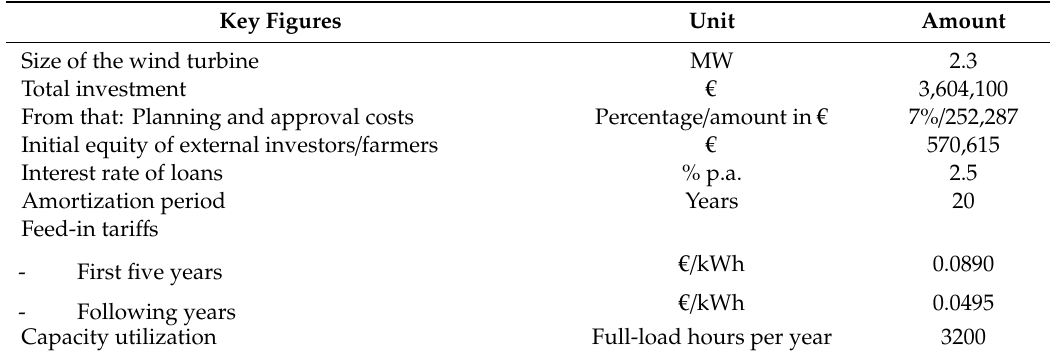
Table 2. Assumptions for the breakeven calculation of a wind turbine.